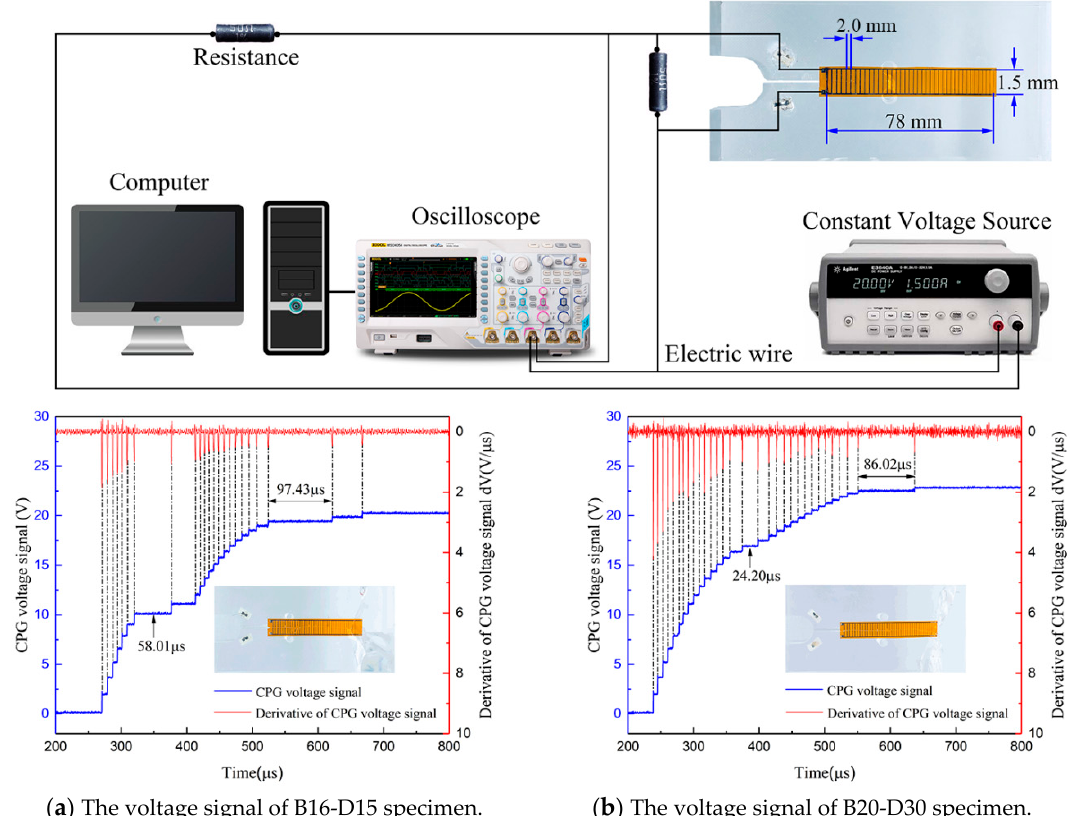
Figure 2. Crack propagation gauge (CPG) test system and the voltage signal curves. ( a ) The voltage signal of B16-D15 specimen. ( b ) The voltage signal of B20-D30 specimen.